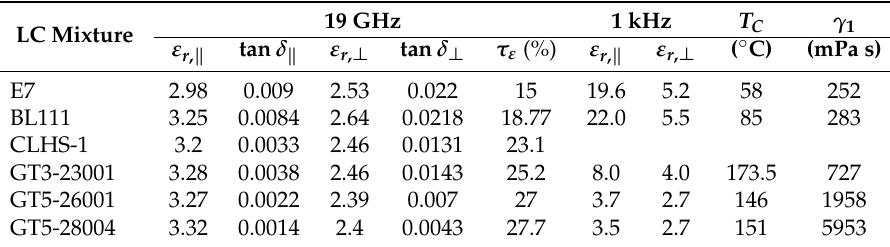
Table 2. Material properties of different LC mixtures at room temperature.